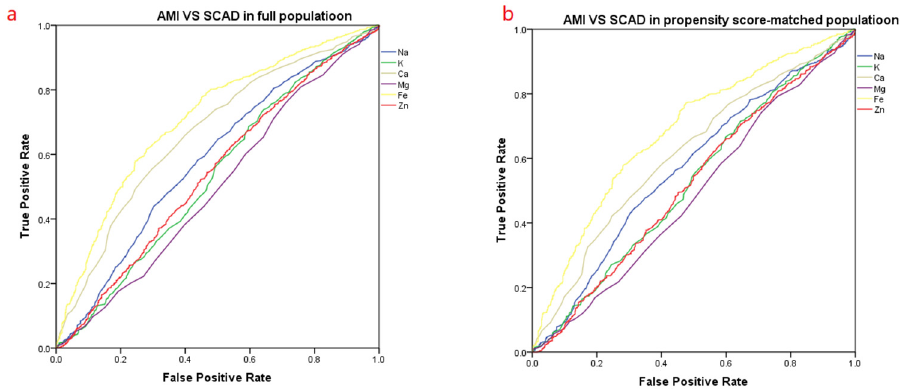
Figure 2. The ROC curve of the AMI vs. the Control group. ( a )The ROC curve before propensity score-matching. ( b ) The ROC curve after propensity score-matching. The area under the curve of the various trace elements is summarized in Table 7.